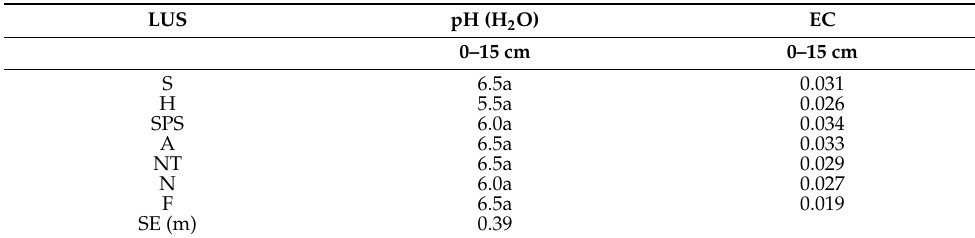
Table 2. The pH and electrical conductivity (EC) in surface (0–15 cm) soil layer, as influenced by different LUS in semi-arid environment. Means with similar lowercase letters within a column are not significantly different at p < 0.05 according to LSD test. See Materials and Methods for detailed information on